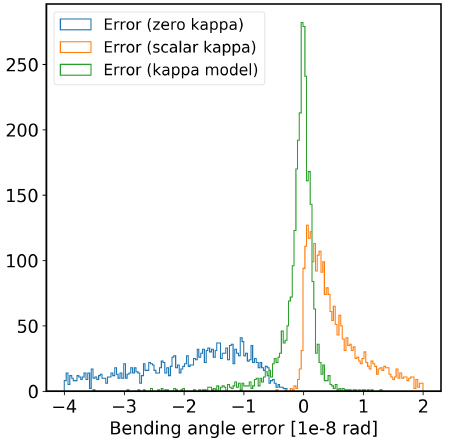
Figure 17. Histograms of daytime bending angle errors for zero κ , scalar κ and modelled κ